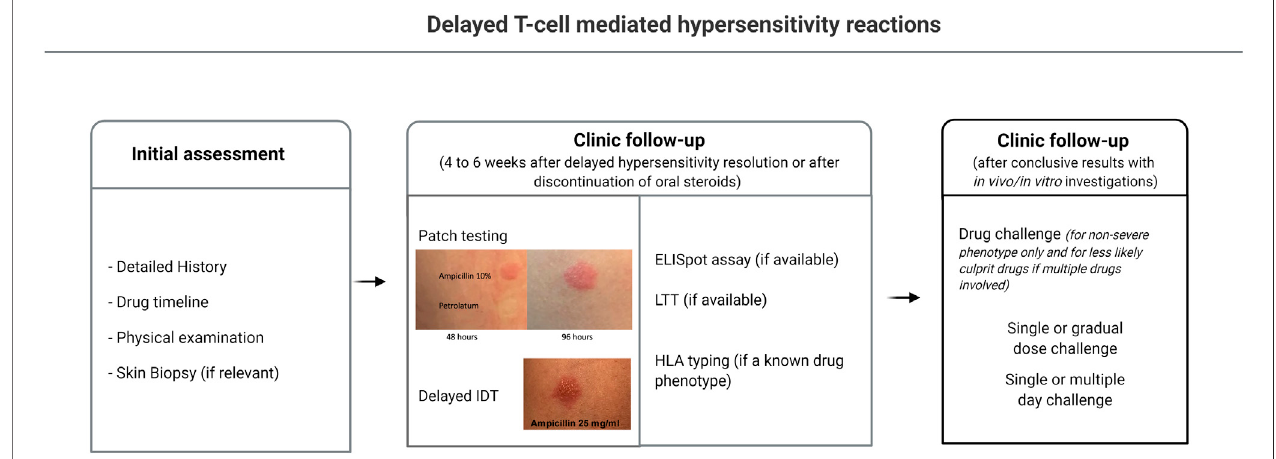
FIGURE2| Diagnosticapproachtodelayedhypersensitivityreactions.1)Clinicalhistoryandidenti fi cationofpossiblecausaldrugs;2)Patch testing;3)Intradermal testingreadingafter24 – 48 h;4) Ex-vivo testing(ifavailable):ELISpot,LTT,HLAalleletesting;5)Singleorprolongeddrugchallengeifconclusiveresults.ELISpot,enzyme linked ImmunoSpot; HLA, human leukocyte antigens; LTT, lymphocyte transformation